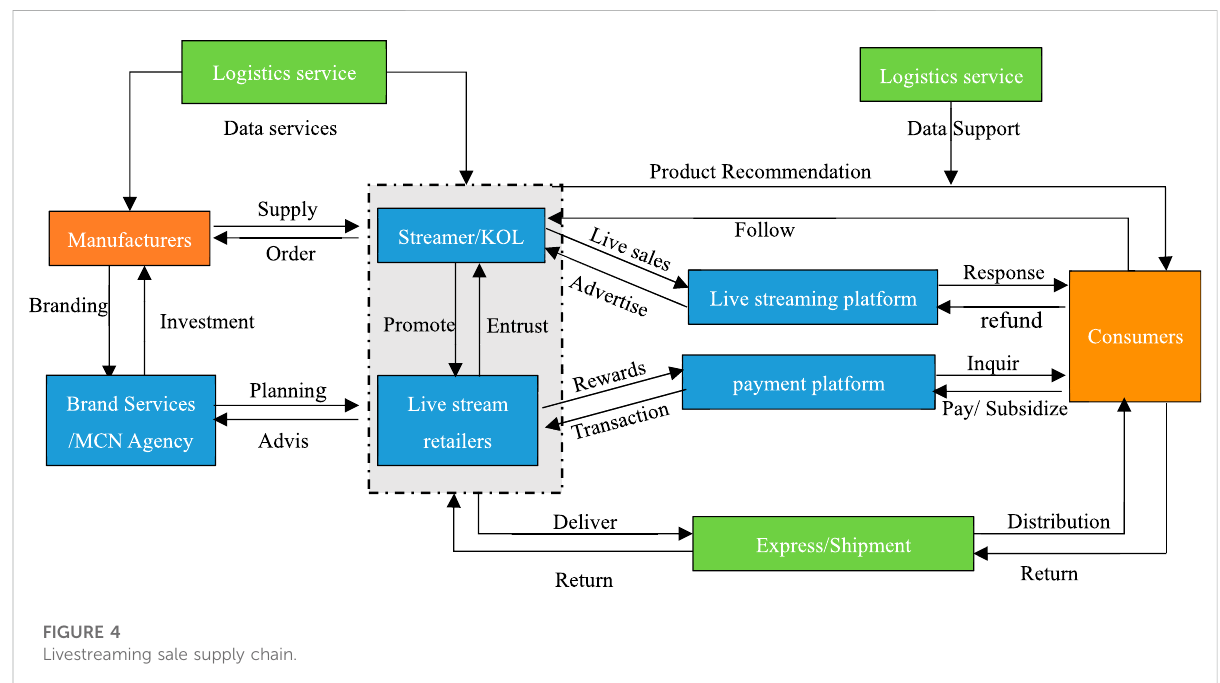
FIGURE 4 Livestreaming sale supply